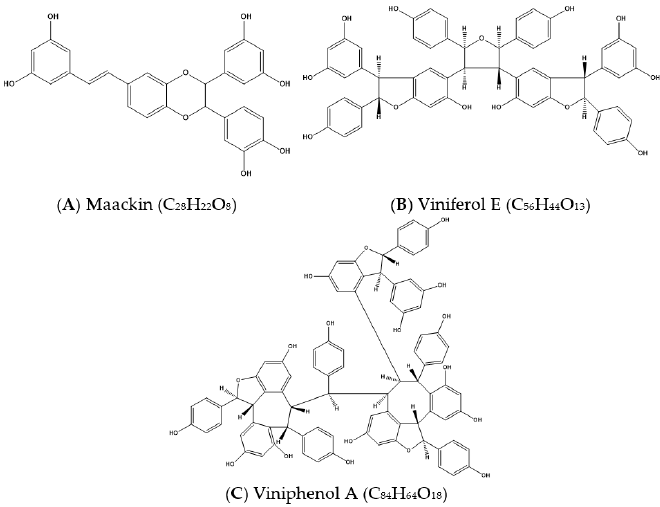
Figure 3. Representative stilbenes tentatively identified in the microencapsulated extract. ( A ) Maackin (C 28 H 22 O 8 ); ( B ) Viniferol E (C 56 H 44 O 13 ); ( C ) Viniphenol A (C 84 H 64 O 18 ). A stilbenoid tetramer (Figure 3B) ( m / z 923.2680, 0.68 ppm) was tentatively identified as viniferol E and yielded product ions at m / z 905.2576, 881.2573, 801.2318, 783.2209 and 707.1898. The product ions at m / z 905.2576 and 881.2573 were due to a loss of H 2 O (18 Da) and C 2 H 2 O (42 Da), respectively, and at m / z 801.2318 probably to the loss of the group C 7 H 6 O 2 (122 Da). The ion at m / z 801.2318 was further fragmented to ions at m / z 783.2209 and m / z 707.1898 by the loss of a water molecule (18 Da) and a phenol group (94 Da), respectively. Viniferol E was previously detected and quantified from grapevine canes by subcritical water extraction